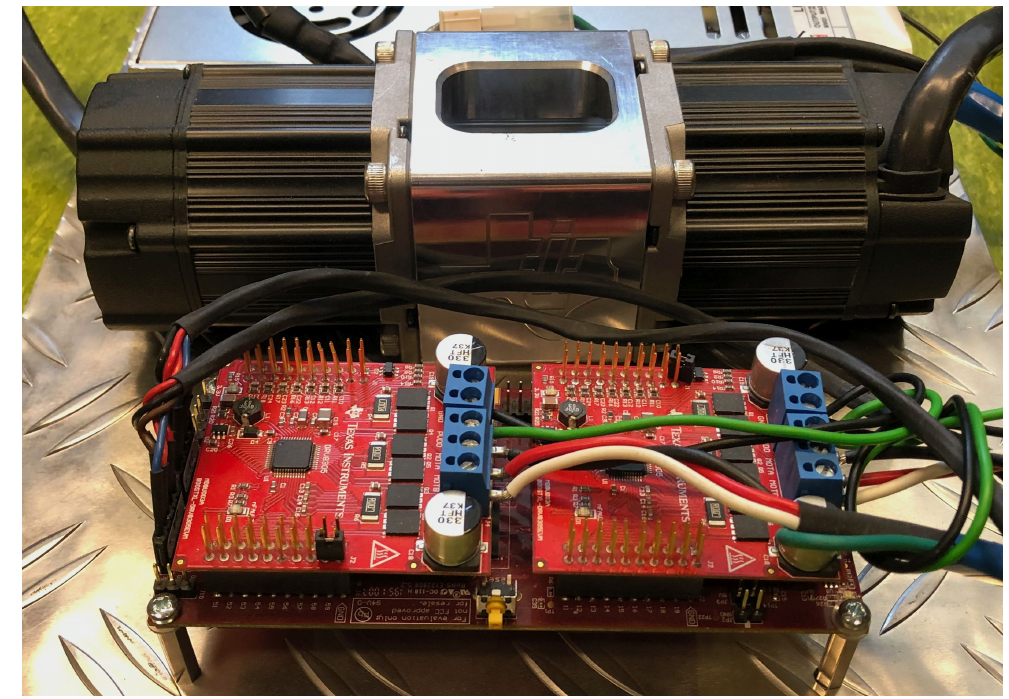
Figure 6. General view of the key components of the laboratory